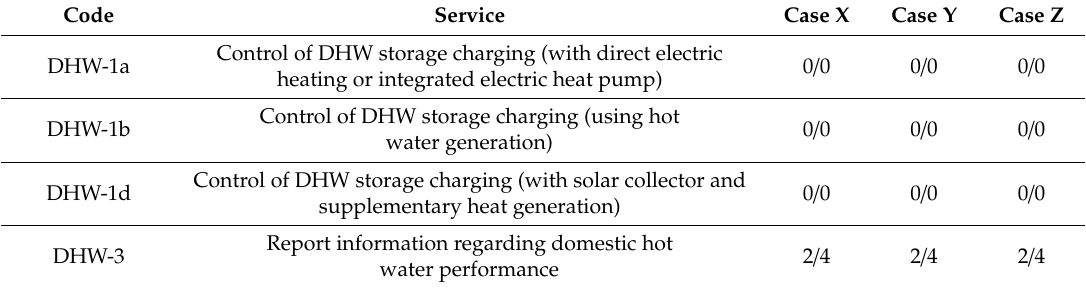
Table 4. The functionality levels in the main domain of domestic hot water